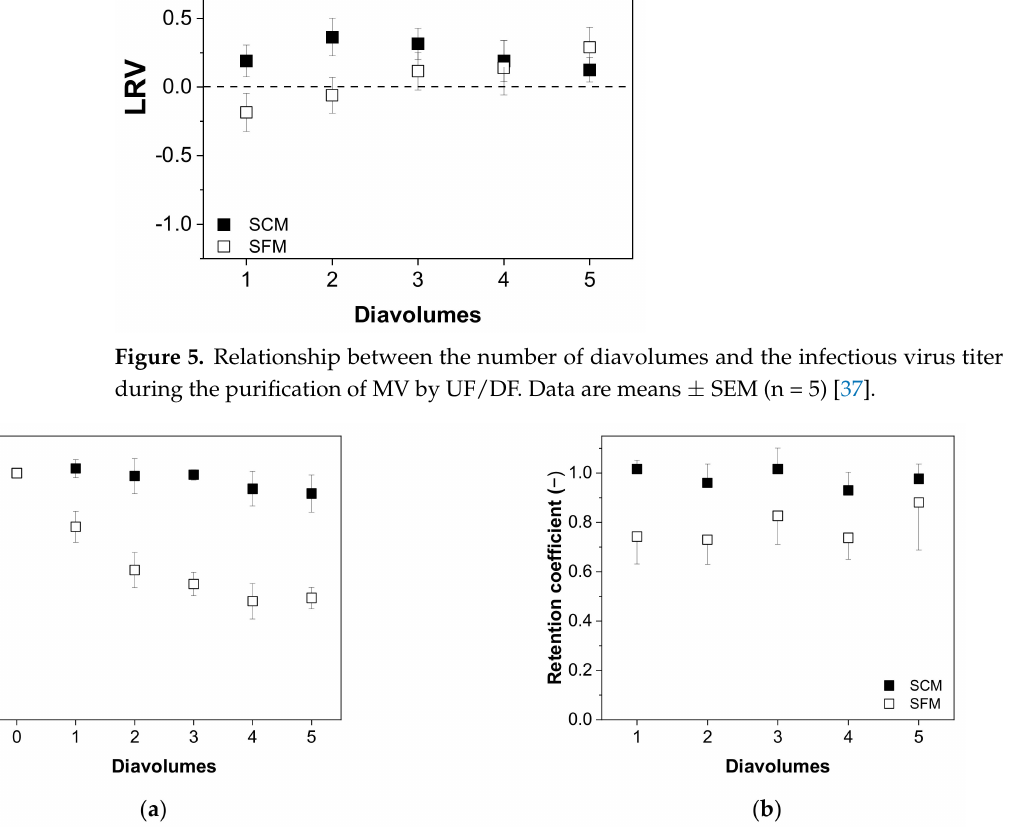
Figure 6. Relationship between the number of diavolumes and ( a ) the relative viral RNA content and ( b ) the MV retention factor during the purification of MV by UF/DF. Data are means ± SEM (n = 5)